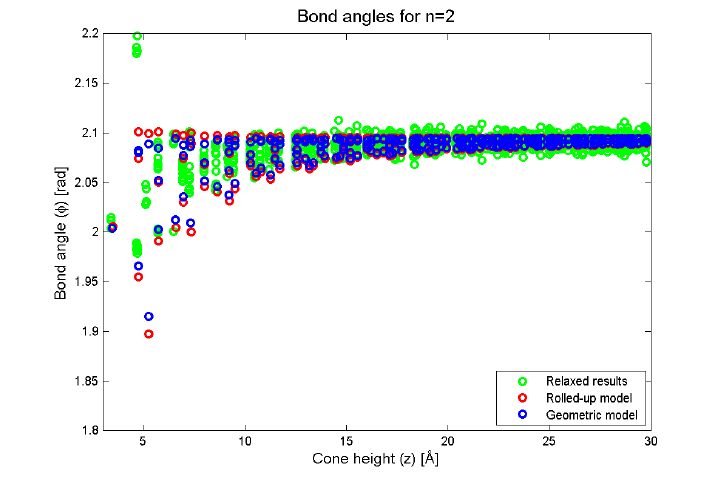
Figure 7. Bond angles as predicted by the rolled-up, new geometric and simulation